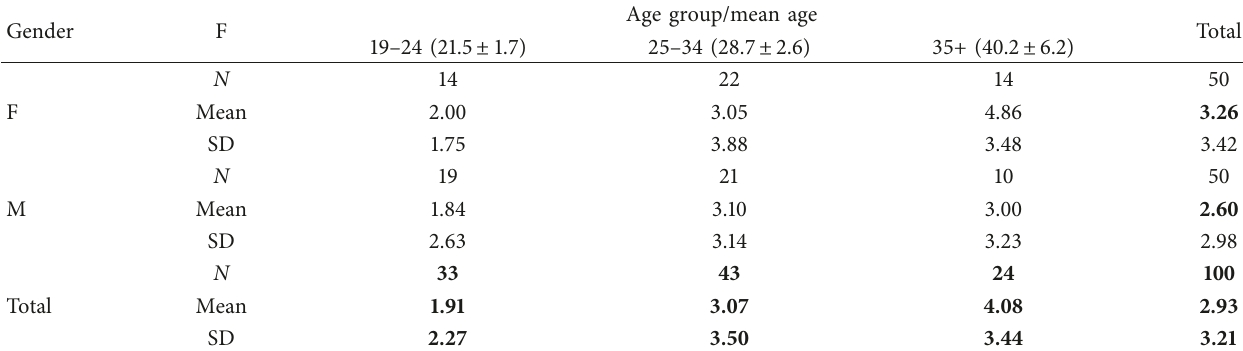
Table 5: Filled (F) value of the adult inmates according to age group and gender.